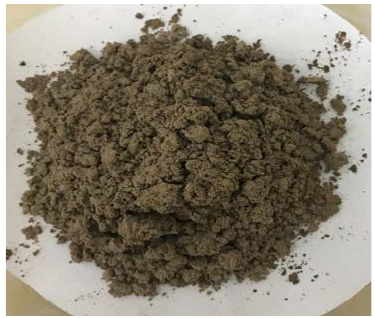
Figure 3. RHF secondary dust.